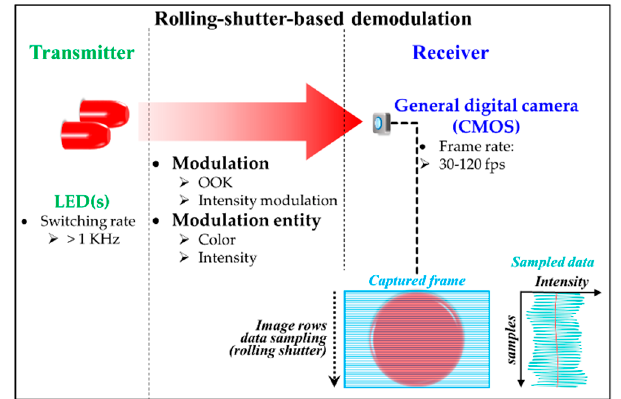
Figure 20. RS-based demodulation process.